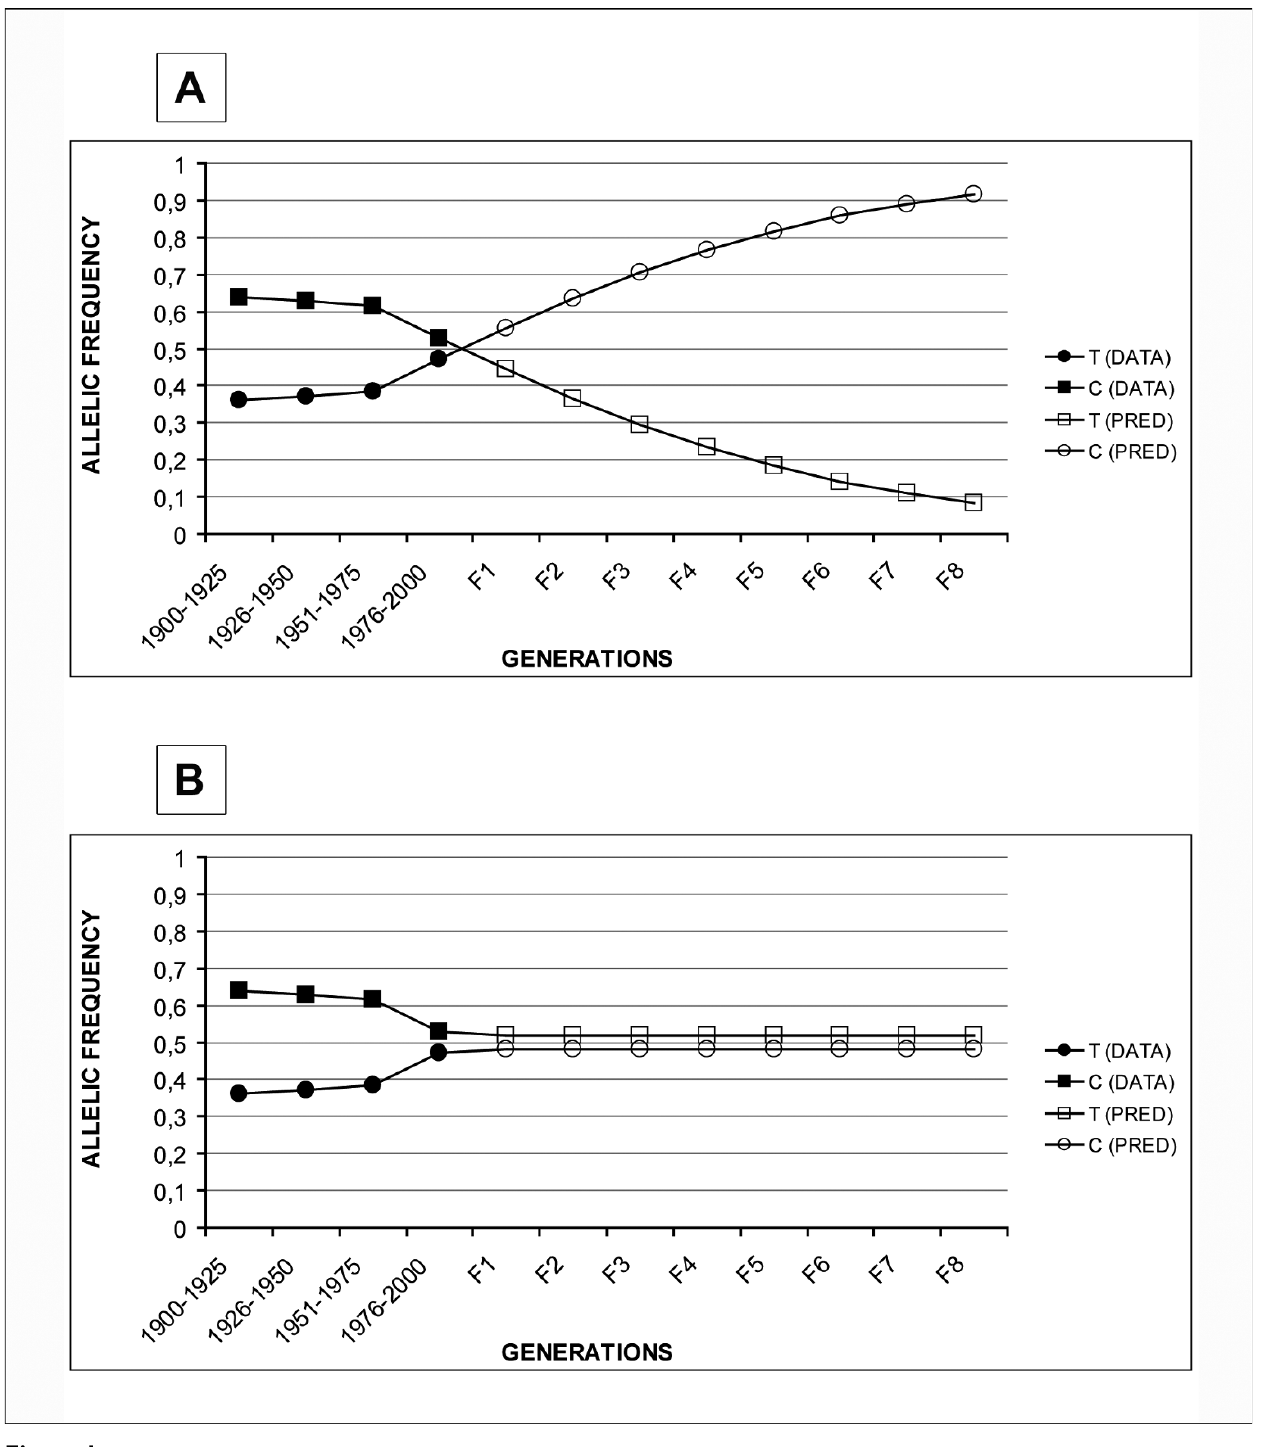
Figure 1 Hypothetical evolution of the allelic frequencies of mthfr 677c>t polymorphism . Panel A represents the observed evolution of the allelic frequencies in the 20th century (DATA) and the hypothetical evolution predicted by the mathematical selection model (calculated fitness: s = 0.5) (PRED). Panel B represents the evolution of the allelic frequencies in the 20th cen- tury (DATA) and the hypothetical evolution based on an allelic balance dependent on folate abundance